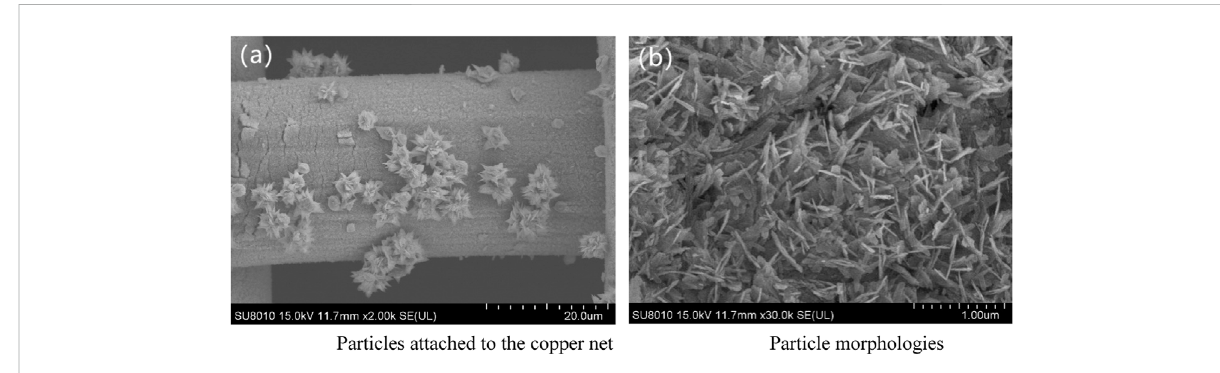
FIGURE 3 Surface morphologies of the super-hydrophilic copper net.